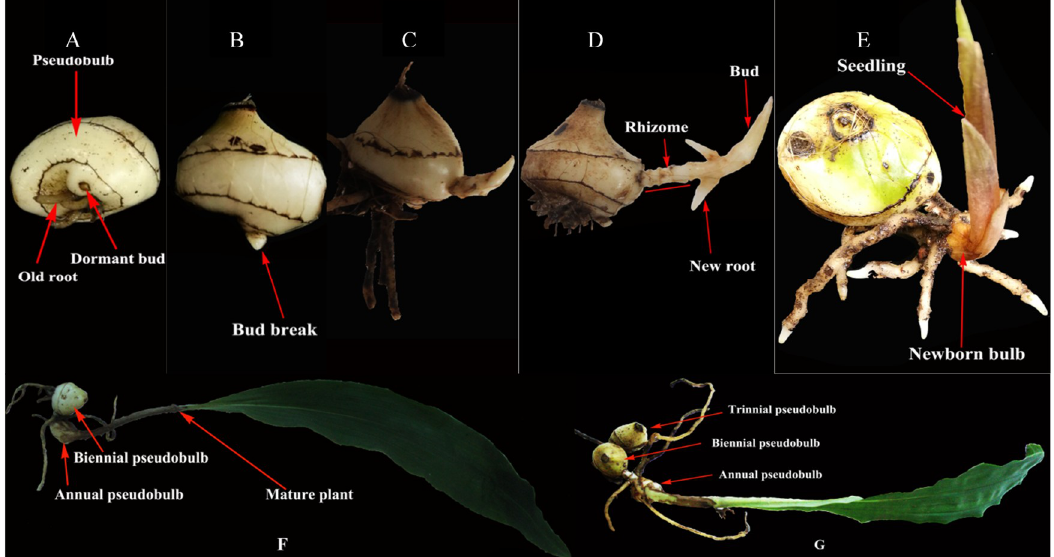
Figure 1. Pseudobulb string formation process: the pictures in ( A – F ) illustrate the development and growth processes of a newborn bulb. Annually, C. appendiculata forms into a biennial plant ( F ) through this development and growth process. Once per year, the biennial plant grows into a triennial plant through recycling ( G ). After repeated growth cycles, this plant forms a pseudobulb string.